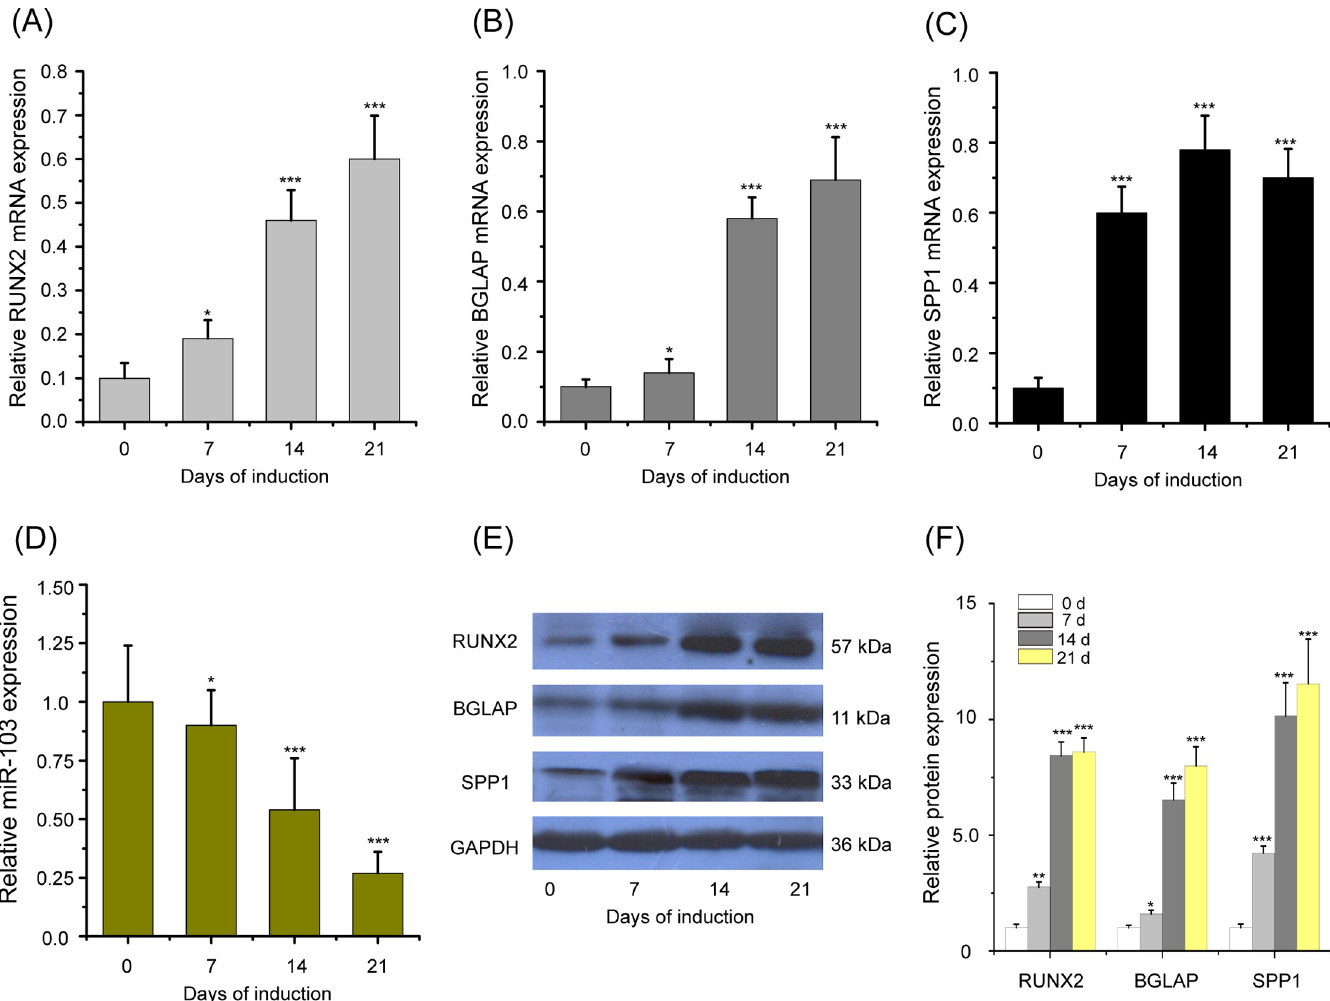
Fig 1. The expression of miR-103, RUNX2 , BGLAP and SPP1 in HBMScs after induction of osteogenic differentiation. Real-time qPCR was performed to detect the mRNA expression levels of RUNX2 (A), BGLAP (B) and SPP1 (C) in HBMScs after 0, 7, 14, and 21 d induction. (D) The expression of miR-103 was markedly reduced in HBMScs during osteogenic differentiation in a time-dependent way. (E and F) Western blot analysis of the protein expression of RUNX, BGLAP and SSP1 in HBMScs during osteogenic differentiation. Columns mean of three independent experiments, and bars SD. � p < 0.05, �� p < 0.01, ��� p <